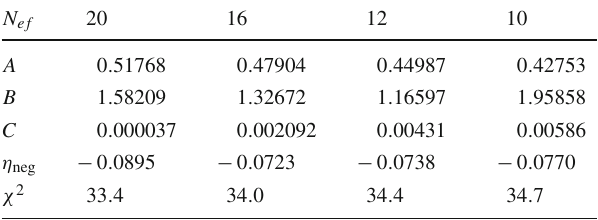
Table 3 Results of the ABC fit performed with different number of eigenfunctions, N ef . All fits were using the same 51 data points, with x < 0 . 001 and Q 2 > 6 GeV 2 . The value of the proton impact factor was b = 10 GeV